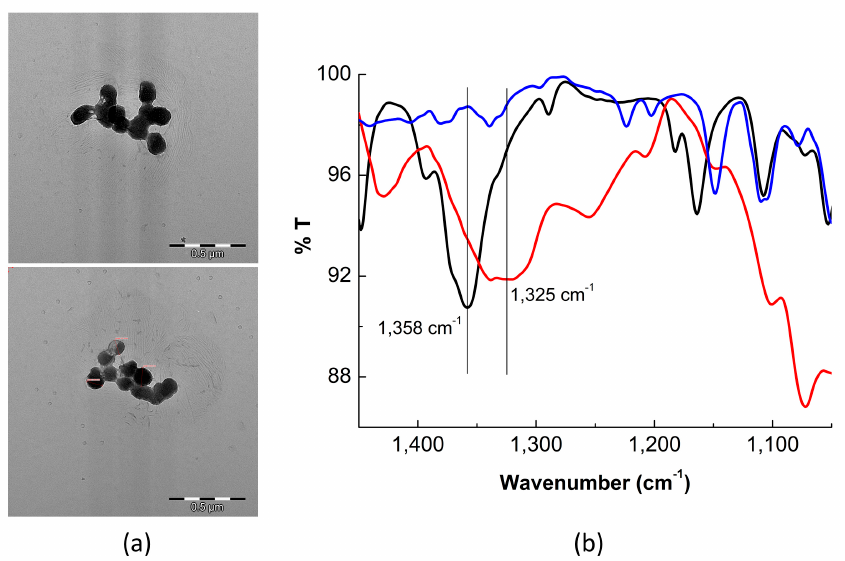
Figure 3. ( a ) TEM images of QD–APBA conjugates. ( b ) FTIR spectra of QD-APBA conjugates in the absence (black) and in the presence (red) of glucose. The FTIR spectrum of glucose (blue) is also added for comparison.